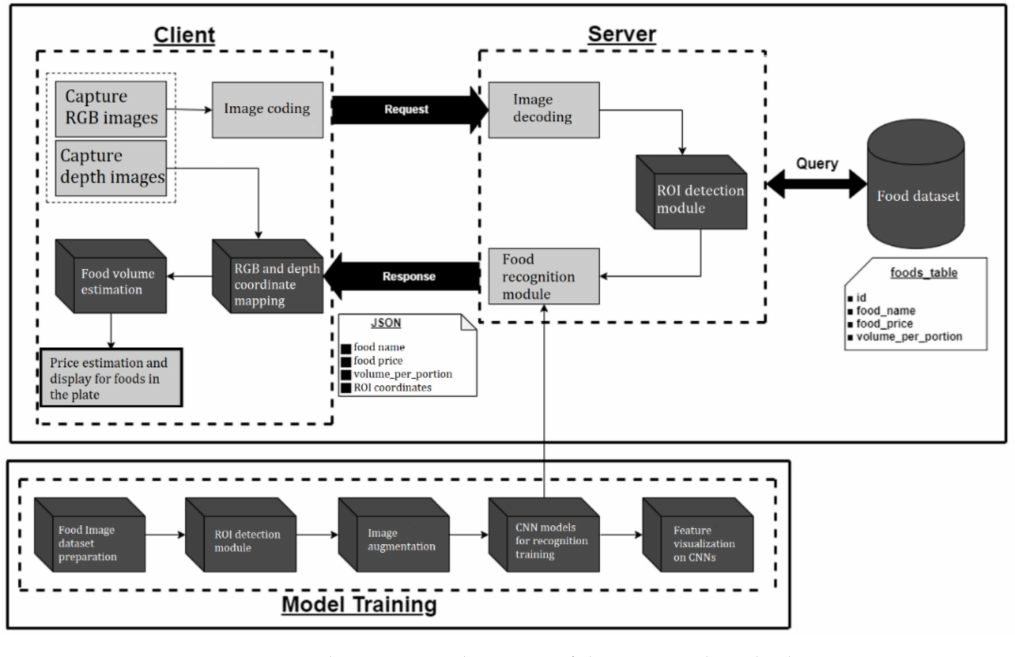
Figure 4. The system architecture of the proposed method.